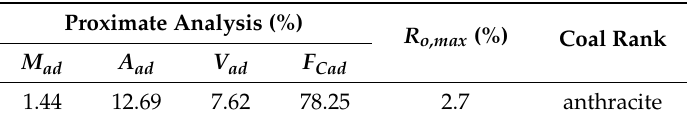
Table 1. The properties of the coal